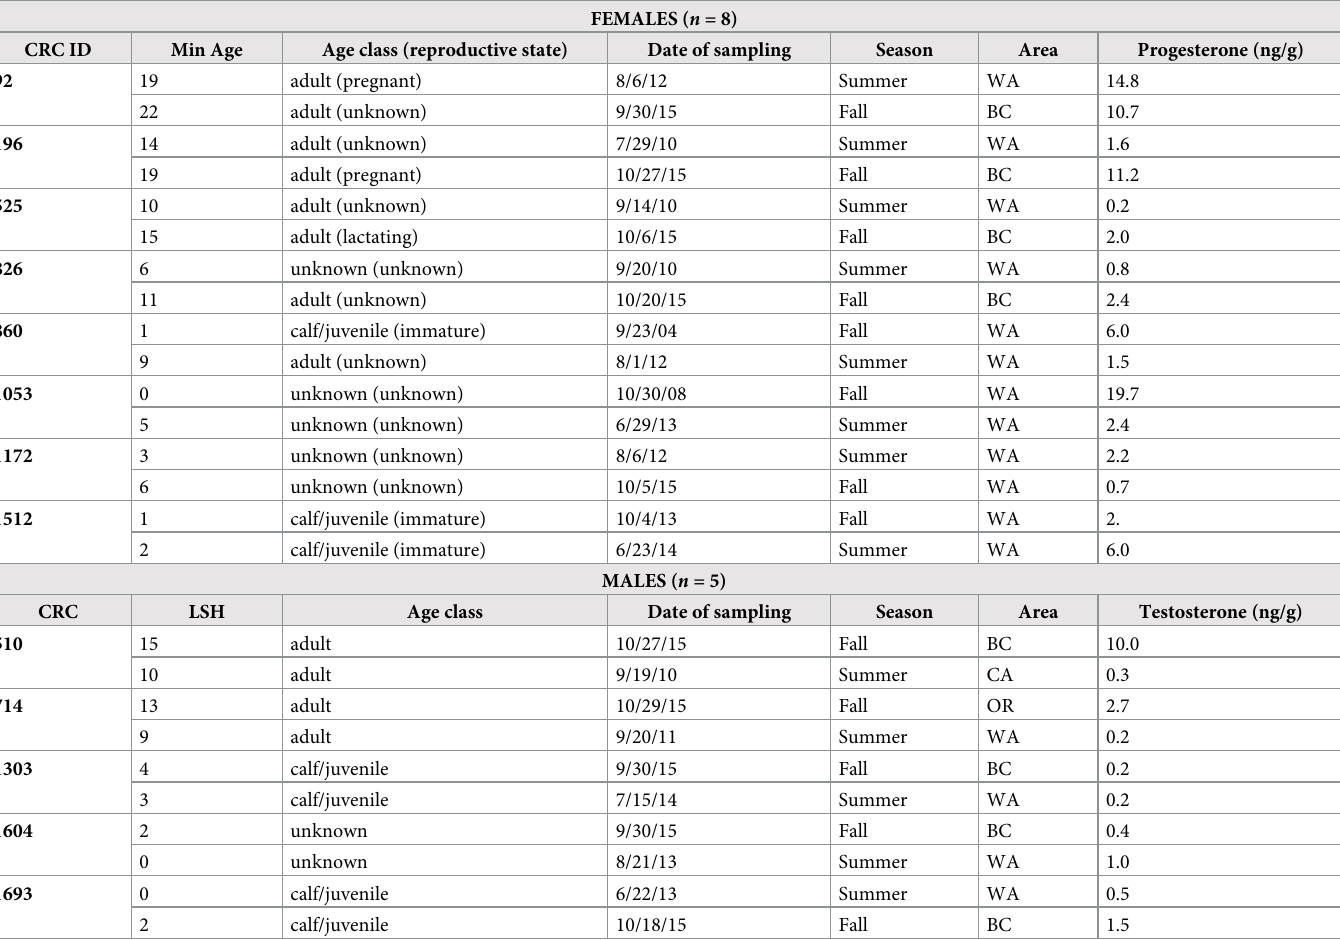
Table 3. Minimum age, reproductive state, date of sampling, season, area, and progesterone or testosterone concentrations in repeated samples collected from eight females and five